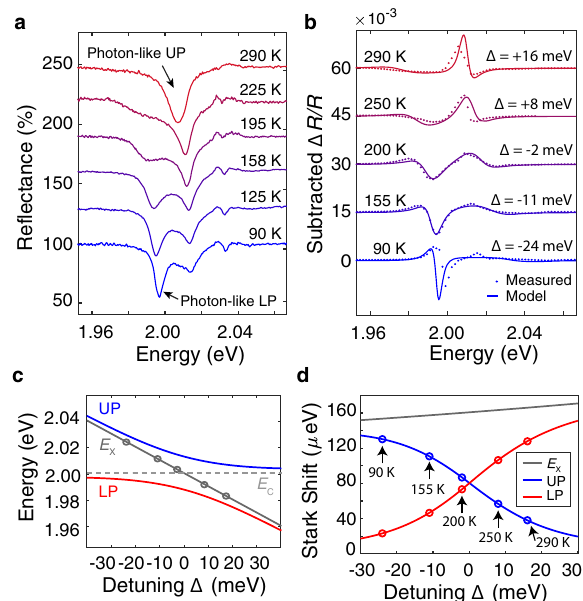
Fig. 3 Valley-sensitive Stark shift over wide range of detunings. a Polariton doublet as a function of temperature offset by 30% intervals. Varying temperature tunes polaritons from positive to negative detuning regime, where UP is more photon-like at high temperatures and LP is more photon-like at low-temperatures. The spectra are normalized to re fl ectivity of the bare cavity, resulting in a small artifact near the 2.037 eV resonant energy of the bare cavity. b Δ R / R spectra at various Δ induced by 1.47 GW/cm 2 pump, offset by 0.015 intervals. The spectra are well-described by the Stark shift model, indicating that the valley-selective polariton OSE persists across detunings. c Model of polariton energies as exciton tunes with temperature. Valley-selective Stark shift measured at cavity-exciton detunings Δ indicated by gray circles. d Stark shift of the upper and lower polariton branches inferred from analysis using Jaynes – Cummings Hamiltonian. The magnitude of the Stark shift tracks the excitonic Hop fi eld coef fi